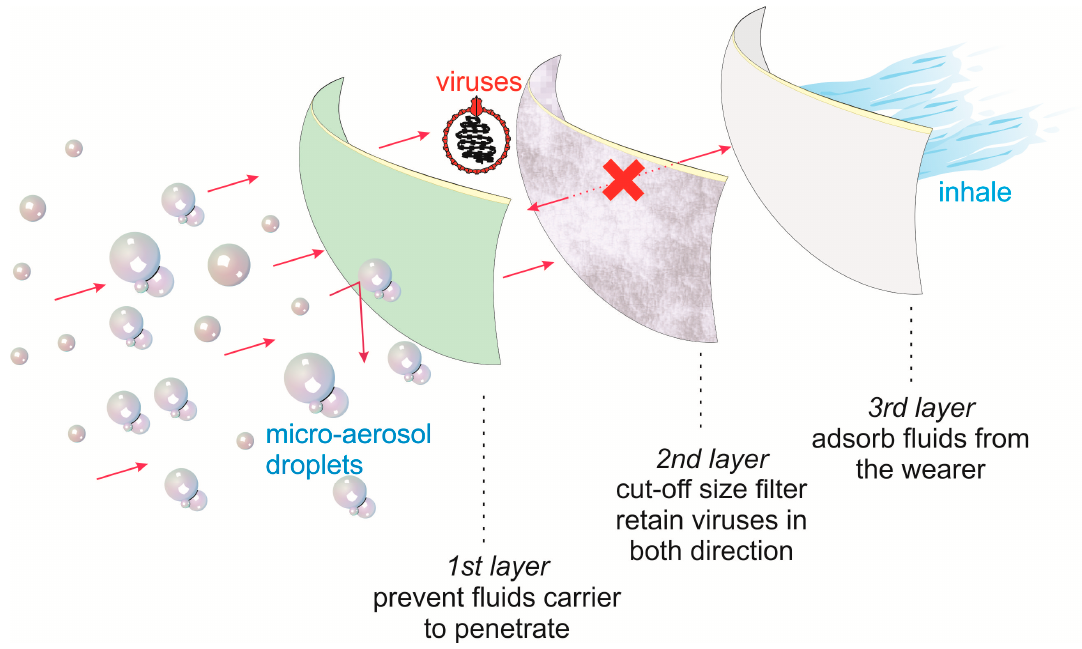
Figure 1. Illustration of the three layers of a surgical face mask to prevent micro-aerosol droplets containing contagious viruses.